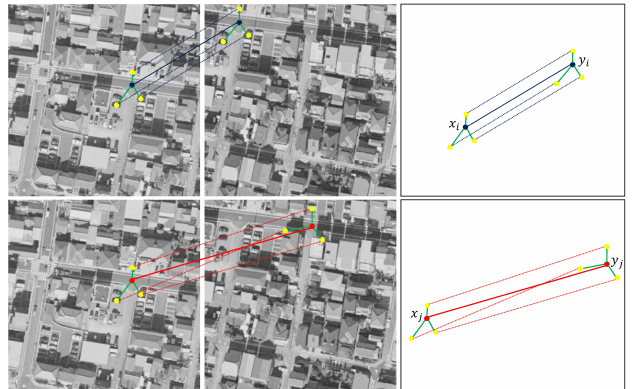
Figure 1. Different neighborhood topological construction shown by inlier ( above ) and outlier ( below ). Blue: true match; red: false match; yellow: neighborhood points; and green: topological construction.